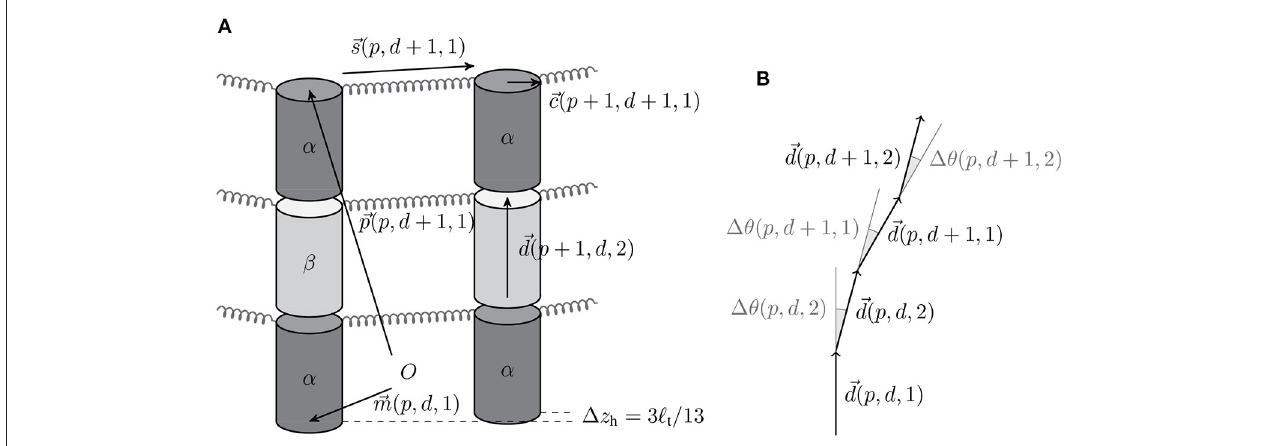
FIGURE 1 | (A) Schematic illustration of the different vectors with the origin O (The vertical gaps between tubulin cylinders are for illustration purposes only). (B) Bending angles between the tubulin monomer direction vectors.